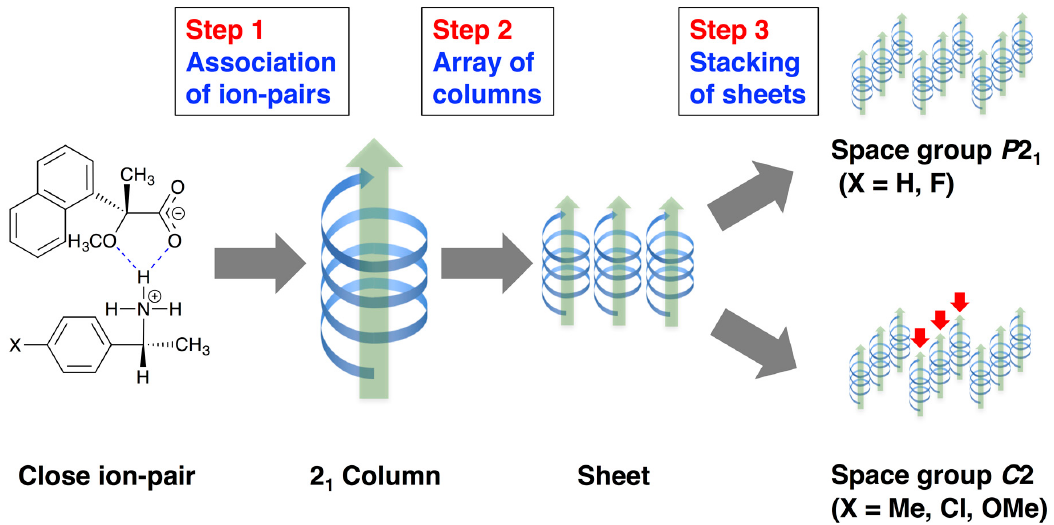
Figure 5. Three-step hierarchical assemblies of M α NP salts.